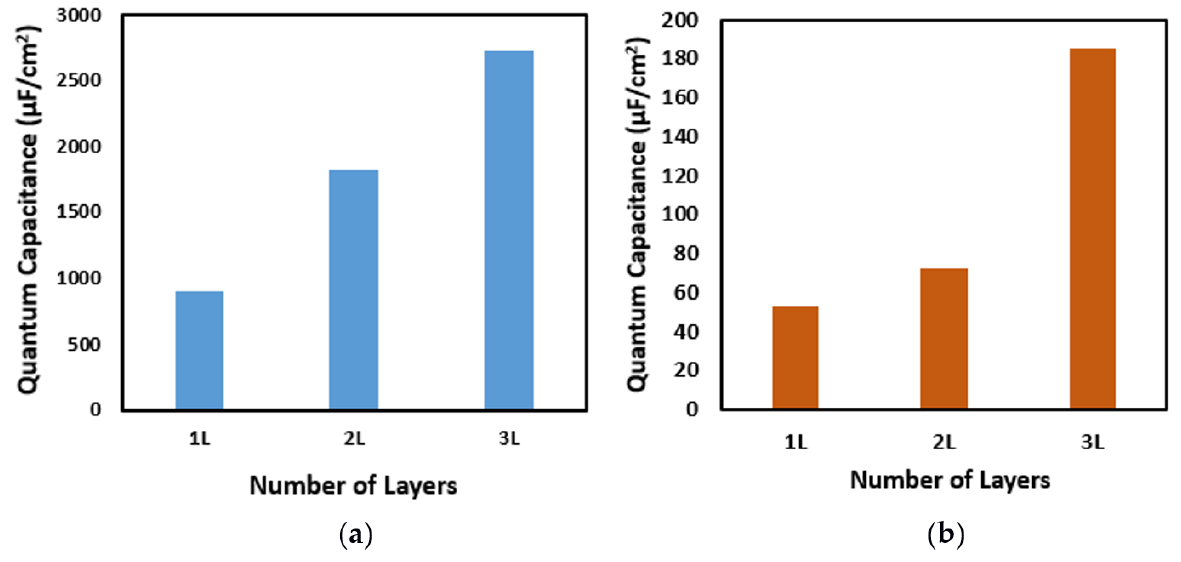
Figure 5. Variation of quantum capacitance QC with number of layers for ( a ) Nb 2 N and ( b ) Nb 4 N 3 . A similar trend of increase in QC with increase in layers is also reported in the case of graphene